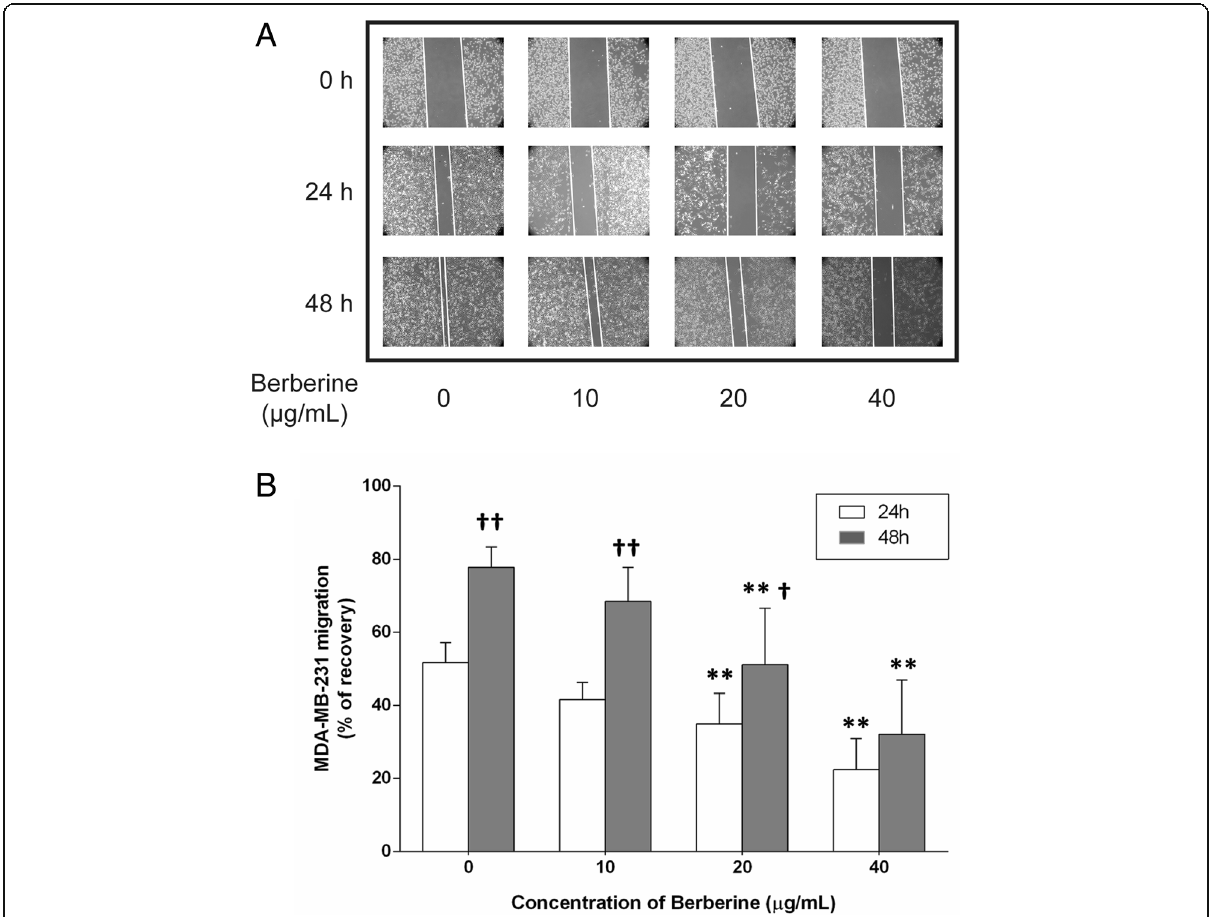
Fig. 3 Effect of BBR on MDA-MB-231 cell migration. Cells were seeded into 12-well plates at 1×10 5 cells per well and cultured to near confluence. The wounded monolayer was incubated in culture medium containing various concentrations of BBR for 24 and 48h. a Representative images of wound healing assays for cells treated with various concentrations of BBR, for 24 and 48h. b The percent recovery as determined in the scratch wound healing assay. Data are presented as the mean±S.D. ( n =3) of three independent experiments. *, p <0.01, compared to the control; † , p <0.05, †† p <0.01, compared to 24h,